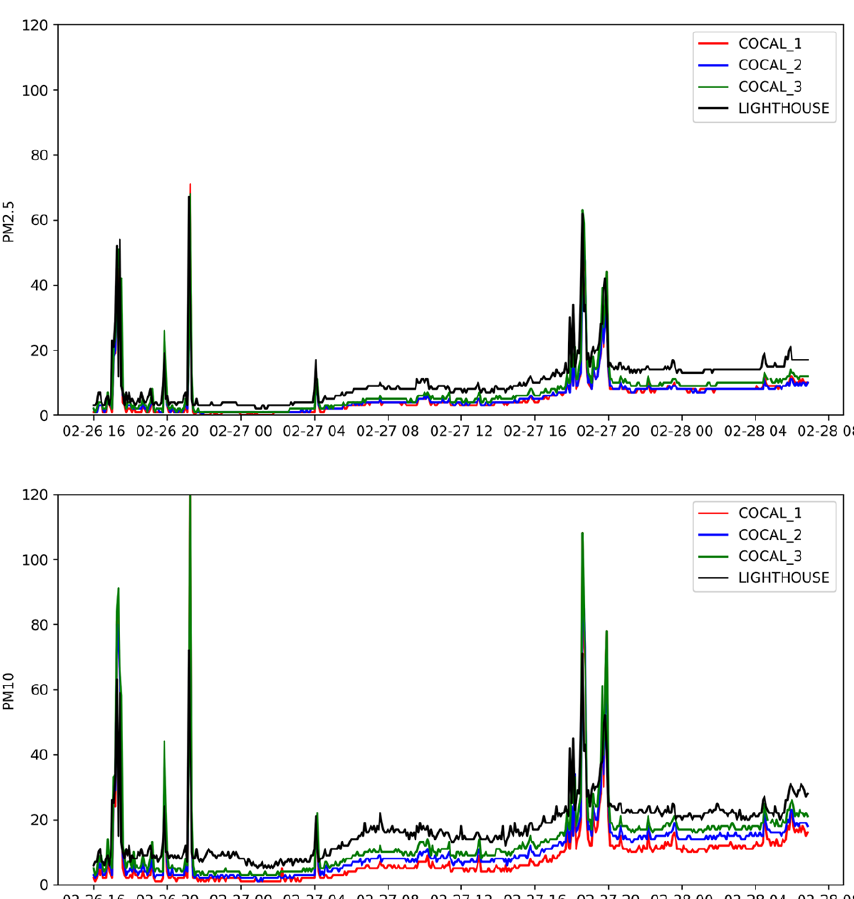
Figure 1. A subset of the time series from which we compared the behavior of LCS (colored lines) with the high-quality PM sensors (black).